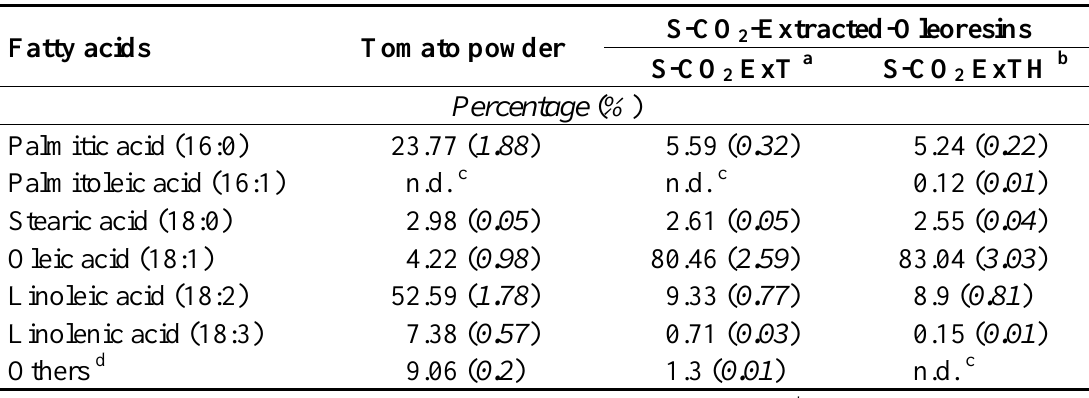
Table 2. Percentage of fatty acids of lipid fraction extracted from dried tomato powder and supercritical CO extracted oleoresins, from tomato and tomato/hazelnut matrices. Values 2 are expressed as percentage of the total lipids. Data are mean ± SD of four measures from three independent